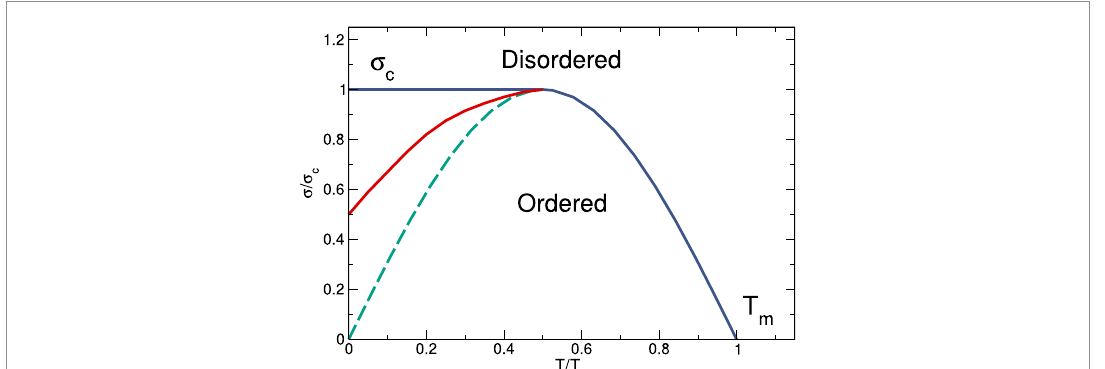
Figure 1. Schematic phase diagram as a function of reduced quenched disorder strength σ/σ c versus reduced temperature T / T m for a 2D assembly of repulsive particles in the presence of quenched disorder. Here σ c is the quenched disorder strength at the threshold for dislocation proliferation at T = 0, while T m is the melting temperature at σ = 0. The green dashed line is the prediction from Nelson [16] showing a reentrant disordered phase. The solid blue line is the prediction from Cha and Fertig [17], and the solid red line is the result we find in this